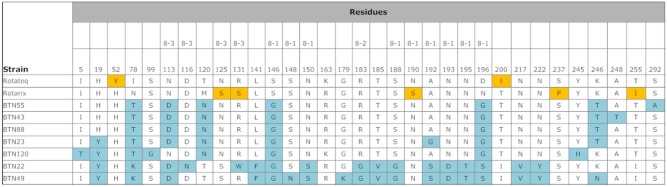
Comparison of the antigenic residues in the VP8* head of VP4 from RotaTeq and Rotarix, and strains circulating in Bhutan.The respective antigenic epitopes are shown above the residue numbers. The amino acid residues in Bhutanese strains that differed from those in the vaccine strains are highlighted. The amino acid residues highlighted in yellow indicate that the residue is different from the other vaccine strain and Bhutanese strains. BTN-22 and BTN-49 belong to lineage 4 of genotype P[8].